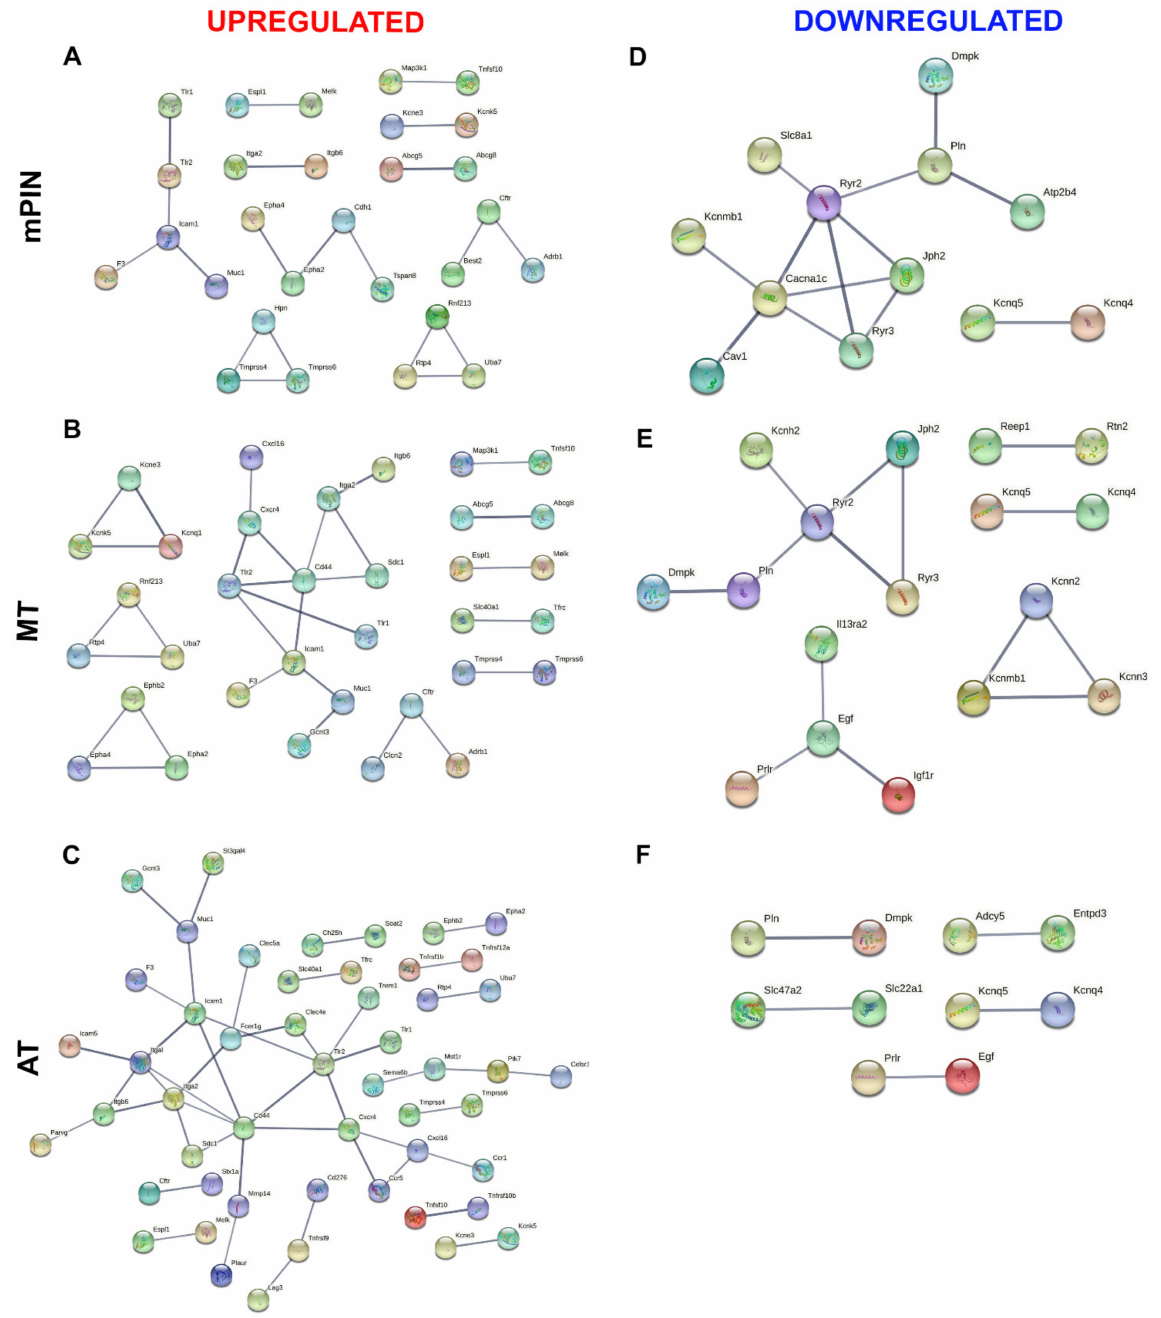
(Figure 4) and secreted proteins (Figure 5) with strong associations represented by thick lines of commonly upregulated genes in mPIN (Figures 4A and 5A), MT (Figures 4B and 5B), and AT (Figures 4C and 5C); a complex interaction network with strong associations of commonly downregulated genes in mPIN (Figures 4D and 5D), MT (Figures 4E and 5E), and AT (Figures 4F and 5F) is noted. The disconnected nodes in the network were hidden.